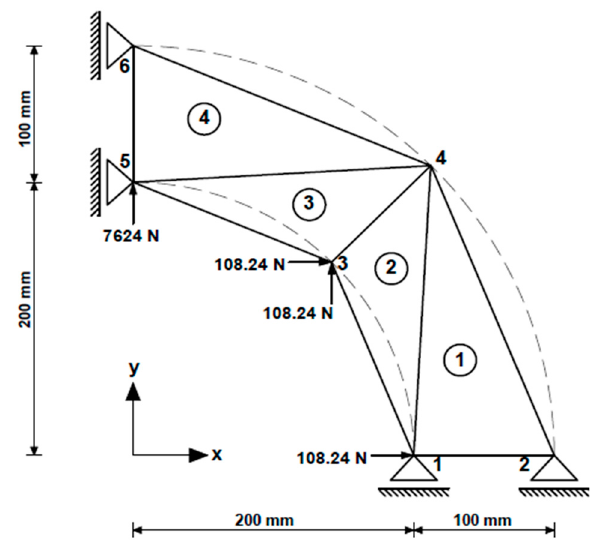
Figure 4. Model of the structural system as a thick-wall pipe with 4 members-6 nodes.